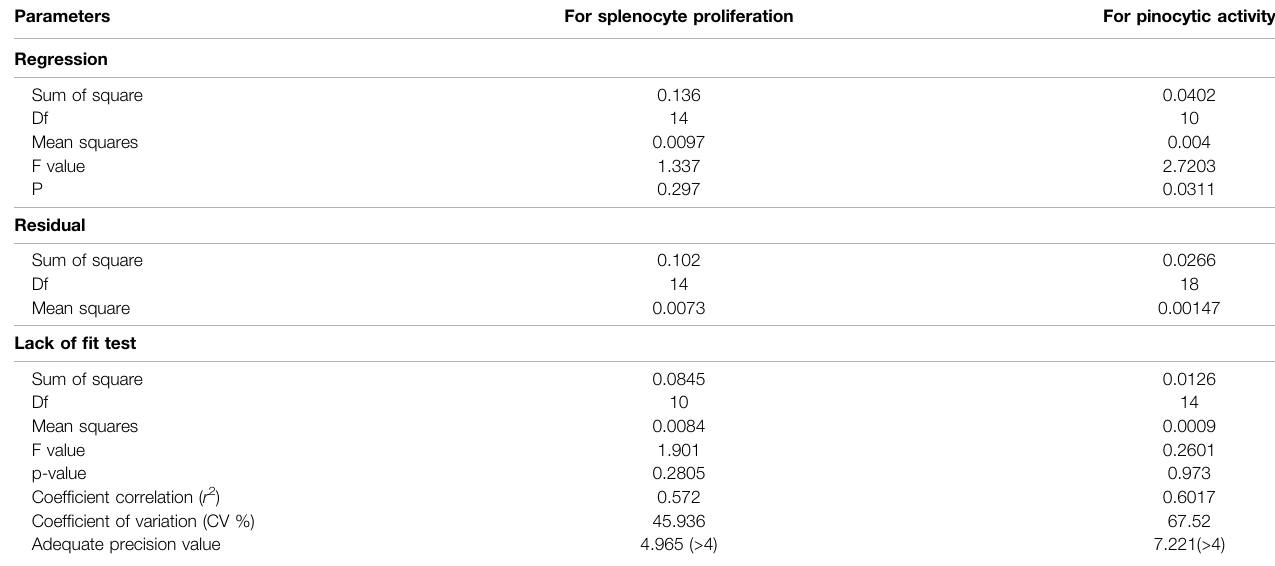
TABLE 2 | ANOVA of the quadratic response surface model for splenocyte proliferation and response surface 2FI model for pinocytic activity in Box – Bhenken design experiments. Parameters For splenocyte proliferation For pinocytic